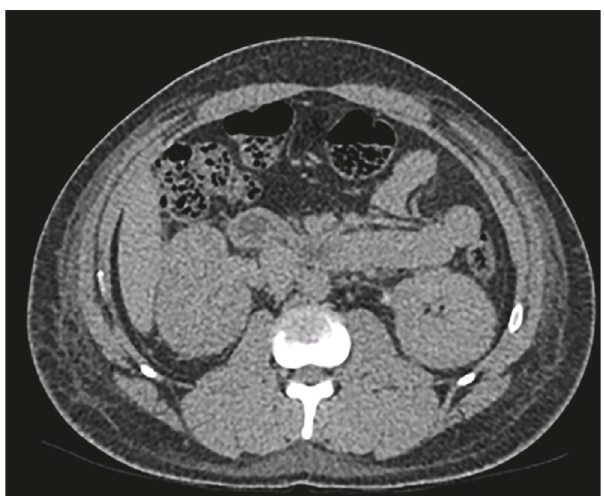
Figure 1: Noncontrast CT section of the abdomen, showing subcutaneous